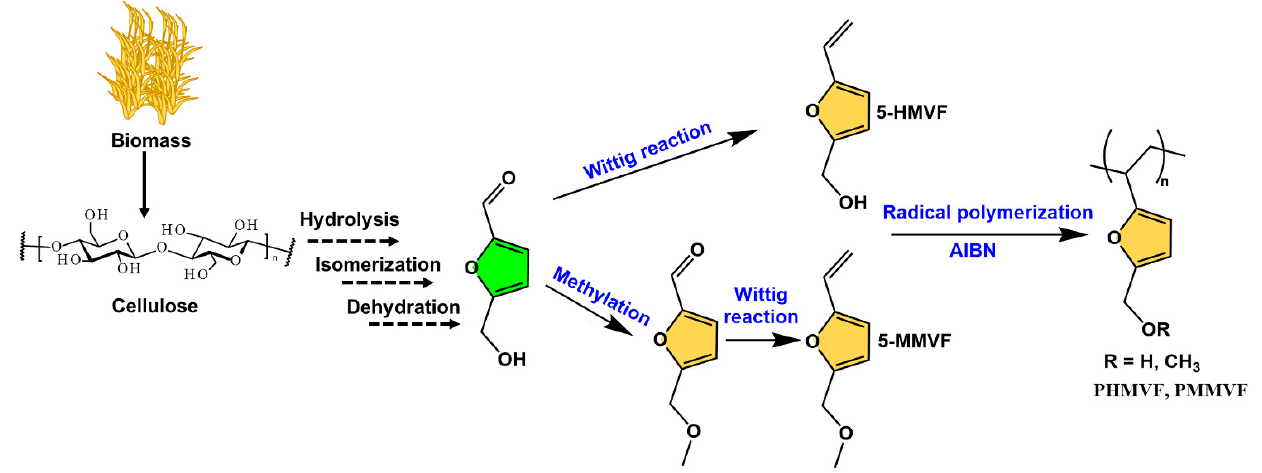
Figure 9. Synthetic routes of 5-HMVF and 5-MMVF bio-based monomers and their free radical